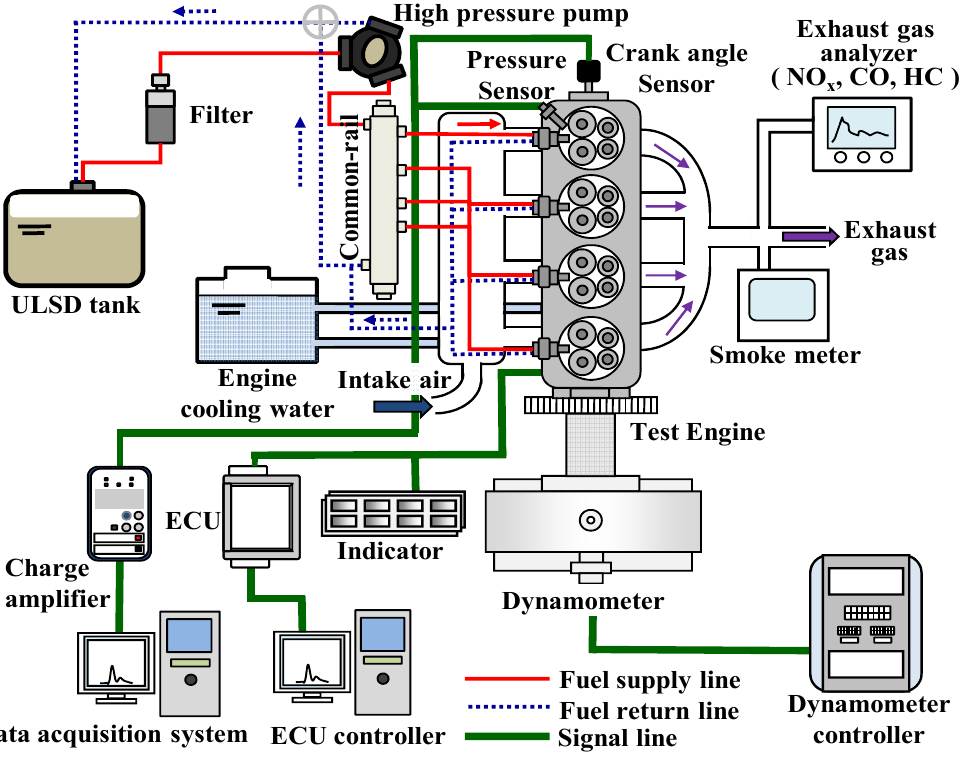
Figure 1. Schematic diagram of experimental setup.